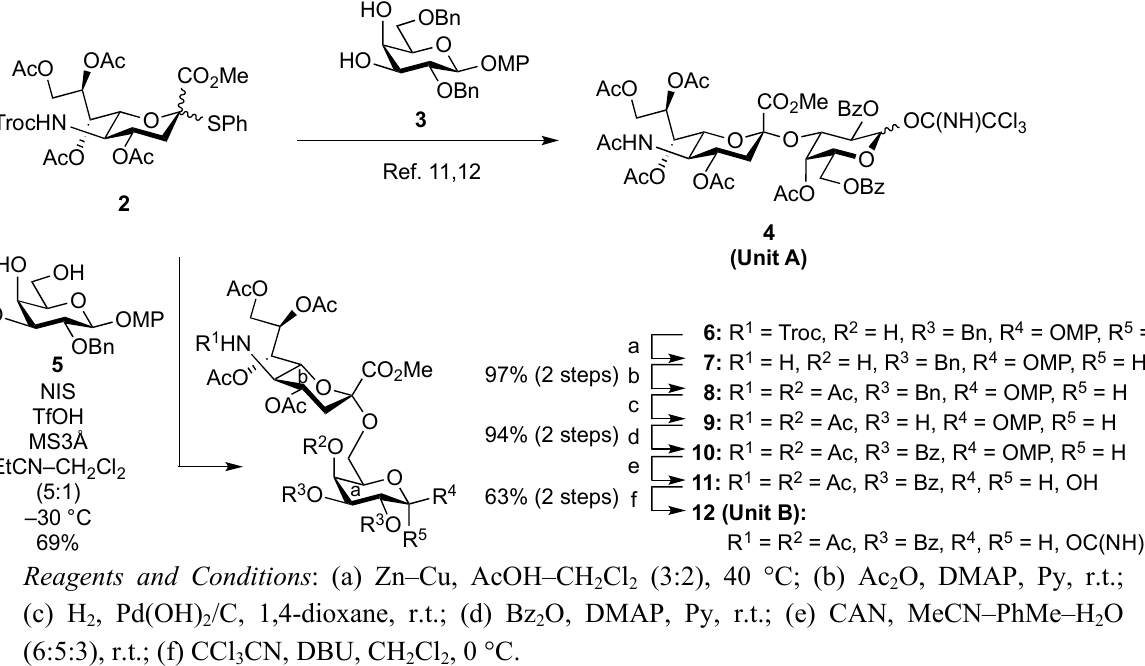
Reagents and Conditions : (a) Zn–Cu, AcOH–CH